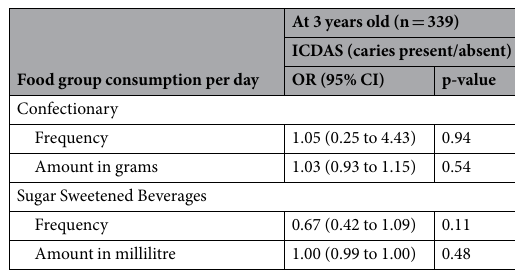
Food group consumption per day